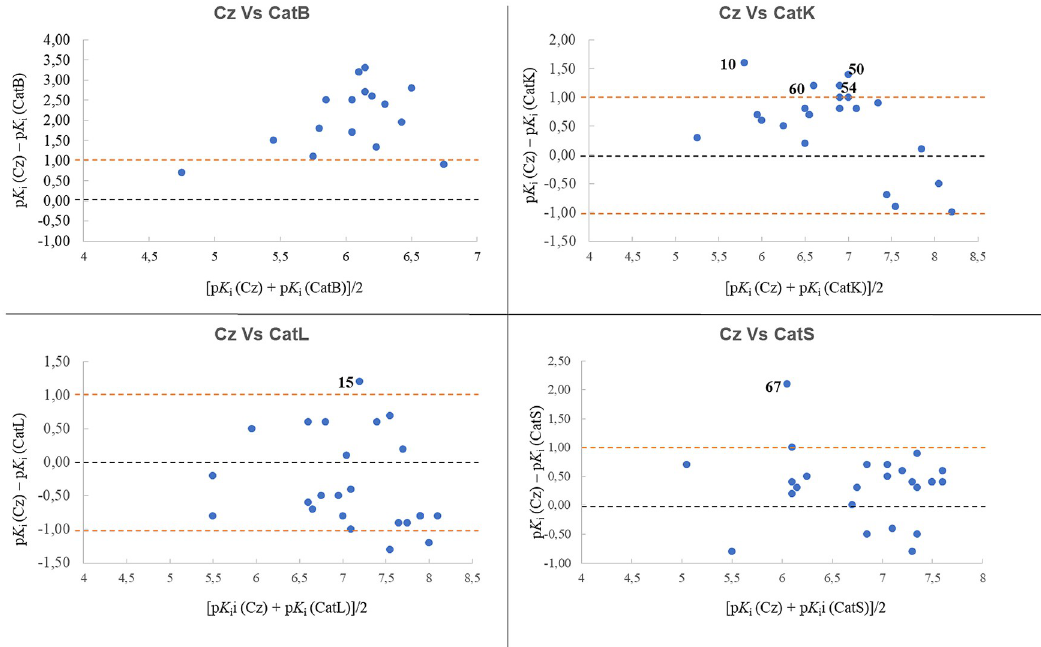
Fig 11. Selectivity pairwise plots. Values are given in p K i . The X-axis represents the difference in p K i for the same inhibitor for a pair of CPs. Y-axis represents the mean value of p K i for the same inhibitor for a pair of CPs. The black dashed line highlights no selectivity. The magenta dashed line highlights a significant selectivity. Positive differences correspond to Cz p K i values that are greater than those for CatB, CatK, CatL or CatS.